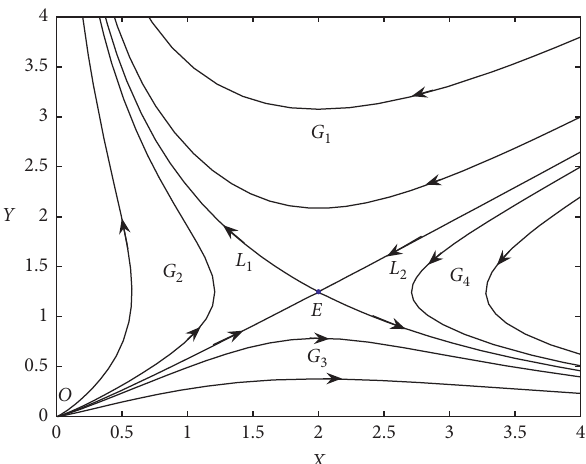
Figure 1: Trajectories of model (1) with parameter values: a � 5 , c � 4 ,d � 6 , and e �